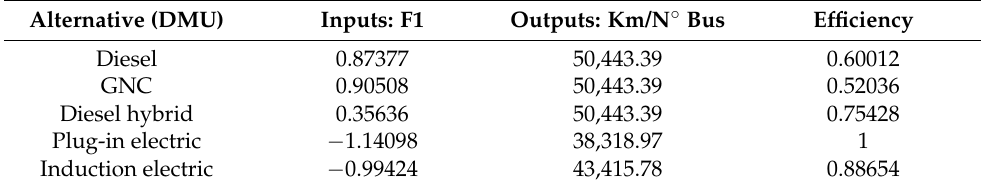
Table 8. Input and output values for each alternative (DMU).